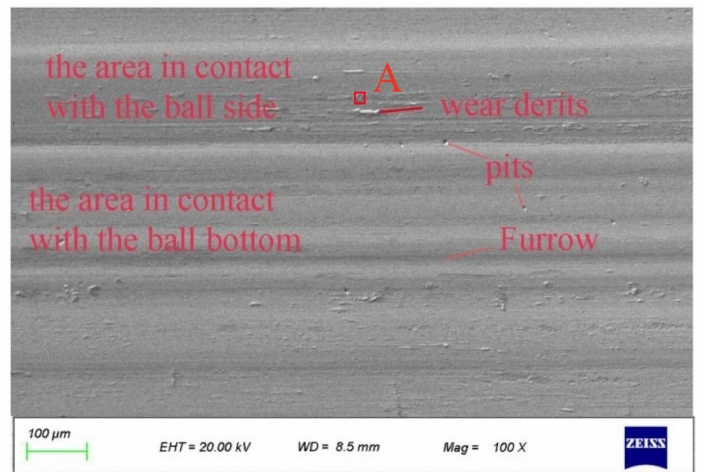
Figure 27. Wear morphology of hardened layer after laser hardening at a scanning speed of 800 mm/min.